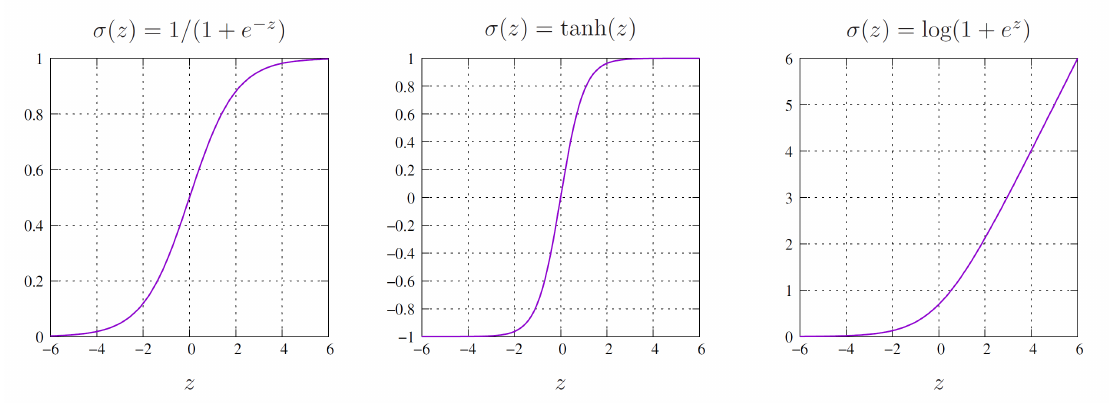
Figure 2. Different types of popular activation functions: logistic sigmoid, hyperbolic tangent and softplus